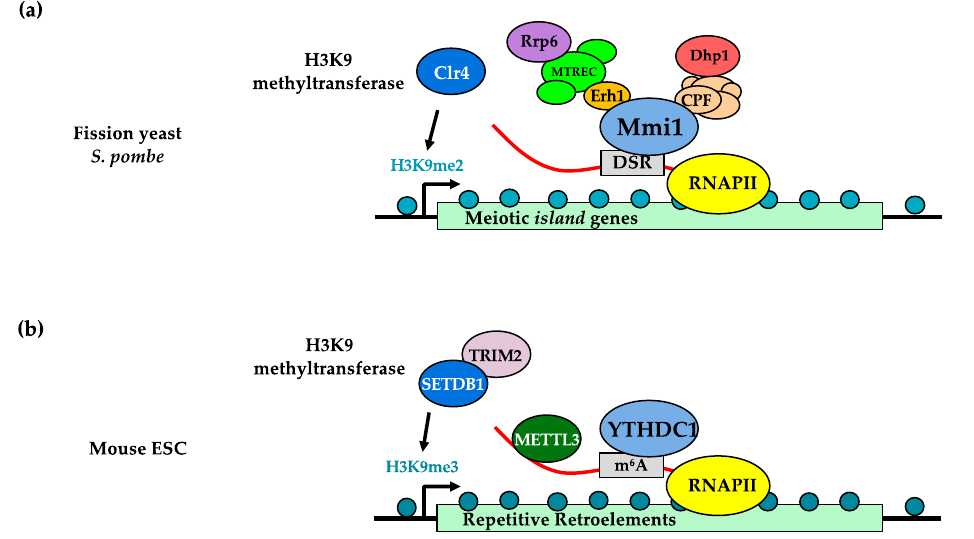
Figure 1. Histone H3 lysine 9 (H3K9) methylation promoted by YTH-family proteins. ( a ) In S. pombe , Mmi1 binds Determinant of Selective Removal (DSR) sequence motifs of meiotic RNAs derived from islands and engages with additional RNA processing and chromatin modification factors to trigger deposition of H3K9me2. ( b ) In mouse embryonic stem cells, YTHDC1 binds to certain m 6 A-modified RNAs to promote chromatin-association of m 6 A-writer METTL3. This promotes SETDB/TRIM28-mediated deposition of repressive H3K9me3 modifications.